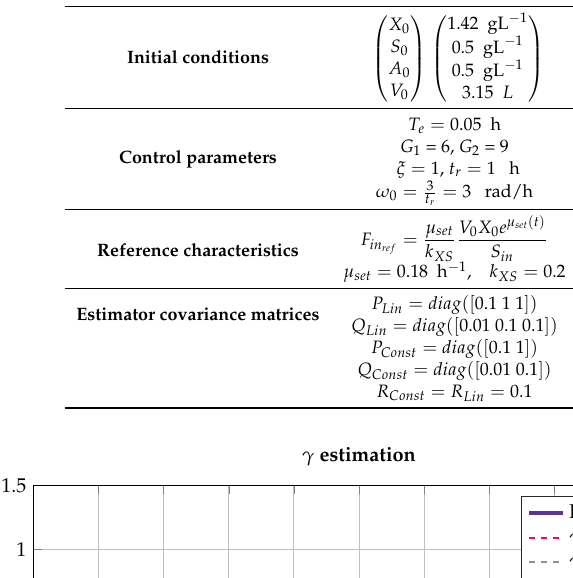
Table 5. Control and estimation parameters.